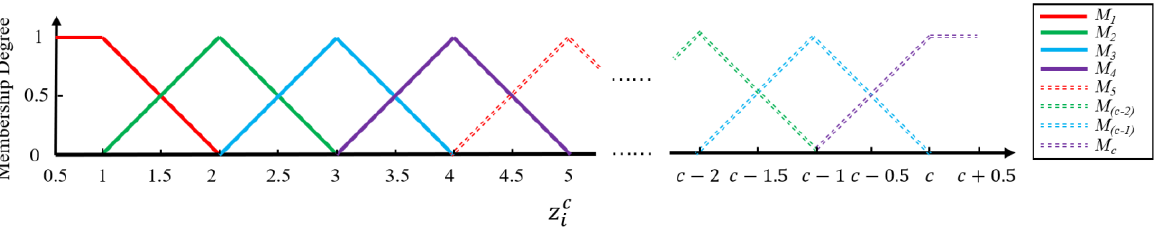
Figure 1. Fuzzy membership